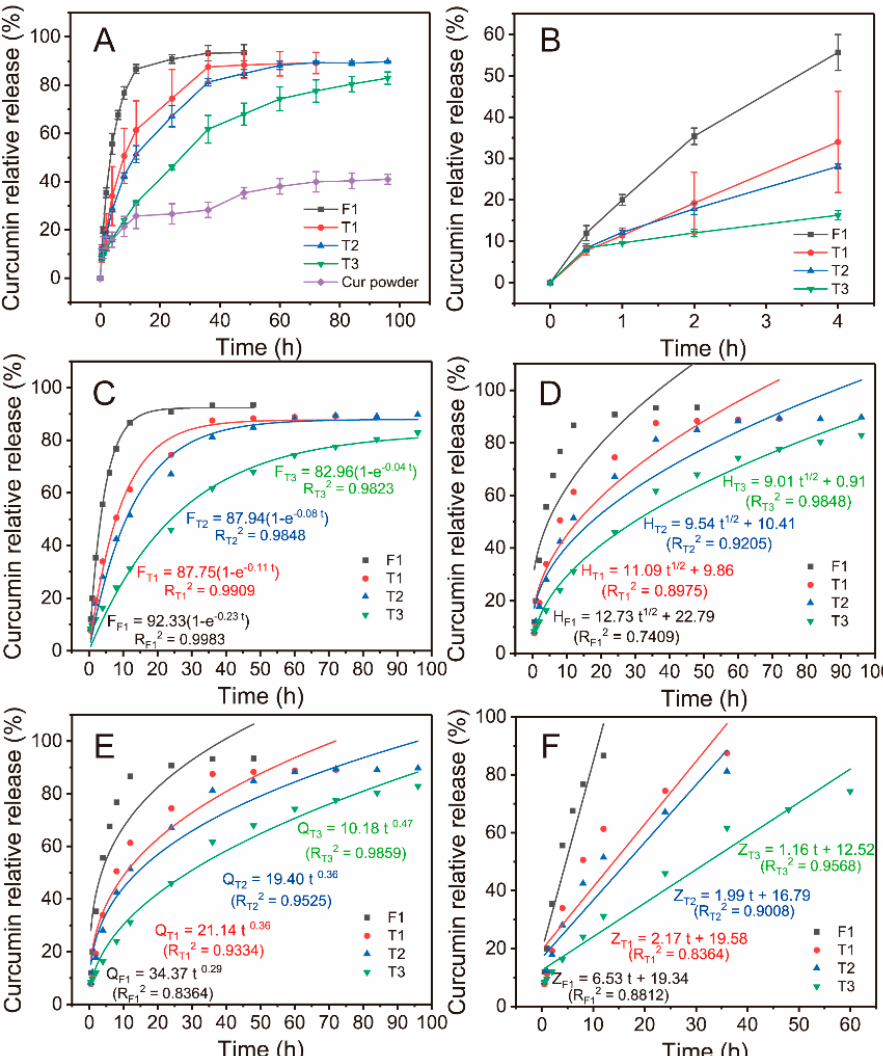
Figure 6. Drug release of prepared fibers. ( A ) Comparison of the relative release of curcumin from different fibers and pure curcumin powders. ( B ) Relative release of curcumin from fibers in the first 4 h. Fitting results of drug data according to the ( C ) first-order kinetic, ( D ) Higuchi, ( E ) Rigter–Peppas, and ( F ) zero-order kinetic models.